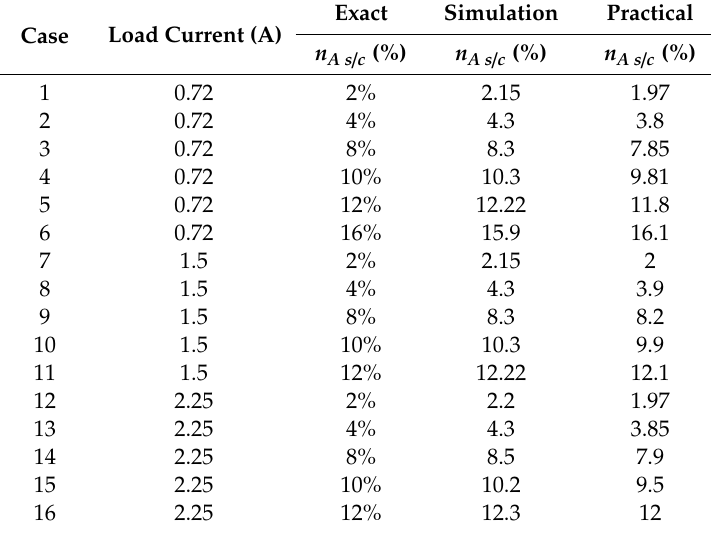
Table 3. EKF estimation response with di ff erent load currents in phase A at a constant